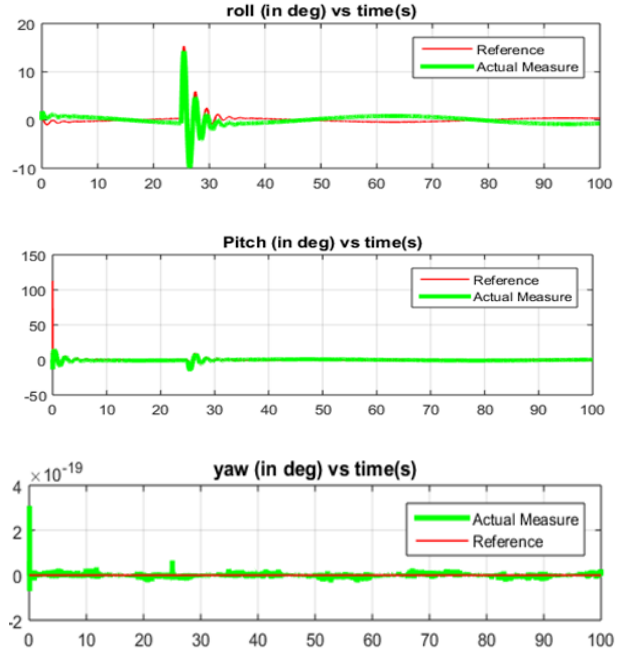
Figure 14. Roll, pitch and yaw response using F-SMC control technique.